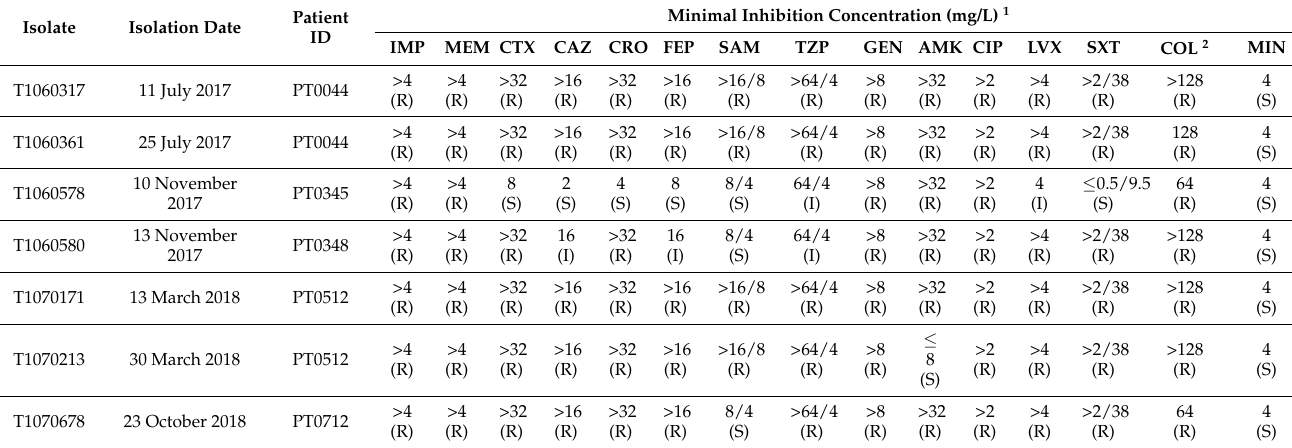
Table 1. Antimicrobial susceptibility testing of the CCR-AB